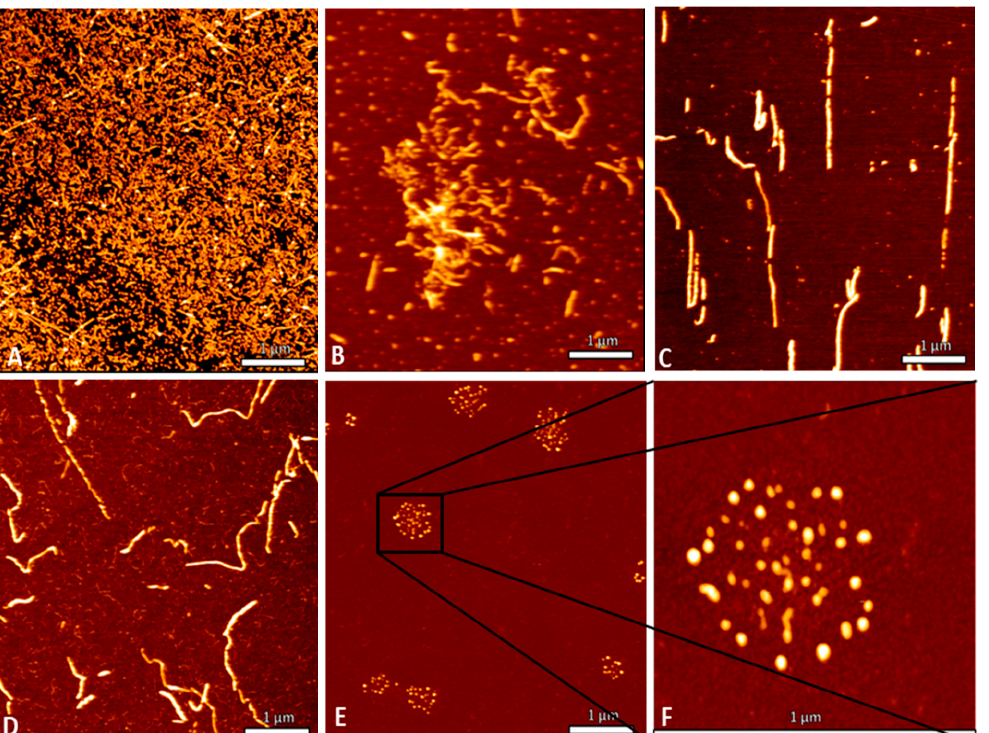
Figure 7. Atomic force microscopy (AFM) measurement using samples obtained after ThT assay with full-length tau 441 aggregation. All AFM measurements were performed by drying 1 µL on mica, followed by two washing steps with 100 µL water and measuring on JPK Nanowizard3 with intermittent contact mode on air and an OMCL AC160TS as a cantilever. The height scale was 0 to 10 nm for ( A , B ), 0 to 5 nm for ( C , D ), and 0 to 20 nm for ( E , F ). ( A ) Control aggregation of full-length tau 441 without any compounds. The whole mica was full of fibrils, and single fibrils were hard to differentiate. ( B ) One to ten dilution of 7A. After dilution, single fibrils became visible, and it was again confirmed that fibrils were present. ( C ) Addition of CP1 did not fully inhibit fibril formation. ( D ) TF2D-5 was added during the exponential phase of ThT-active tau aggregation. Here, the amount of tau fibrils that were found was less when compared to the control. ( E ) Addition of TF2D-5 at the start of the experiment. No fibrils were observed in these samples. Instead, clusters of spots were found throughout the mica, most probably resembling drying artifacts. ( F ) Enlarged representation of ( E